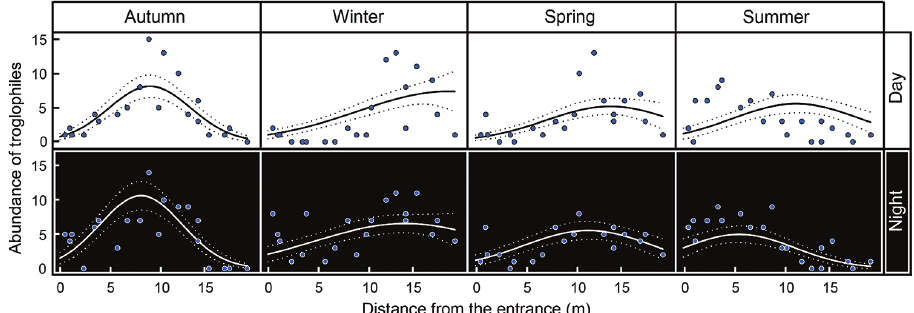
Figure 5. Predicted values (filled lines) and 95% confidence intervals (dotted lines) of the effect of dis- tance from the main entrance in interaction with the sampling season on the abundance of troglophiles derived from the generalized linear mixed model (GLMM). Day and night trends are